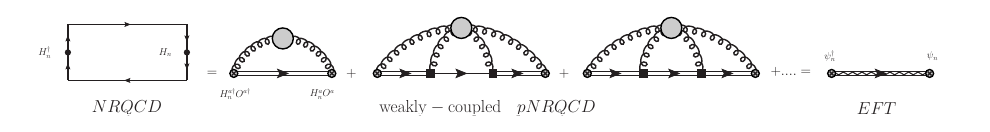
Figure 2. Matching diagram for the static potential. The double, single and curly lines represent the heavy-quark-antiquark octet, singlet and the gluon (cid:28)eld respectively. The black squares stands for multipolar vertices from the weakly coupled pNRQCD Lagrangian, the circles with a cross for the light degree of freedom operators and the shaded circle represents nonperturbative gluon